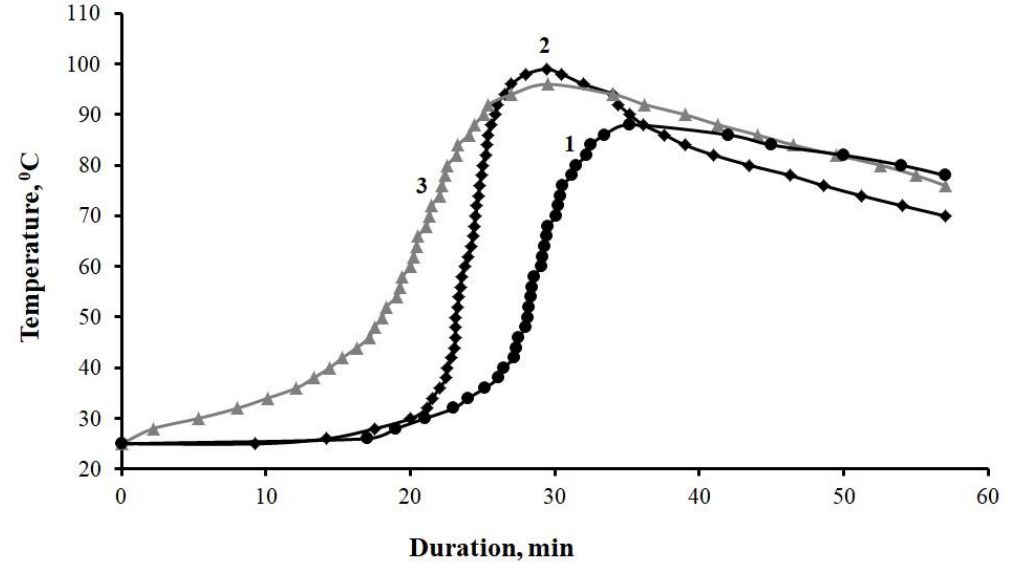
Figure 8. Kinetic curves of the curing process of compositions, parts by mass: 1—100ED-20 + 40ORPP + 15PEPA; 2—100ED-20 + 40ORPP + 0.5Ocher + 15PEPA; 3—100ED-20 + 40ORPP + 75Ocher + 15PEPA. Table 3. Values of the curing process of epoxy